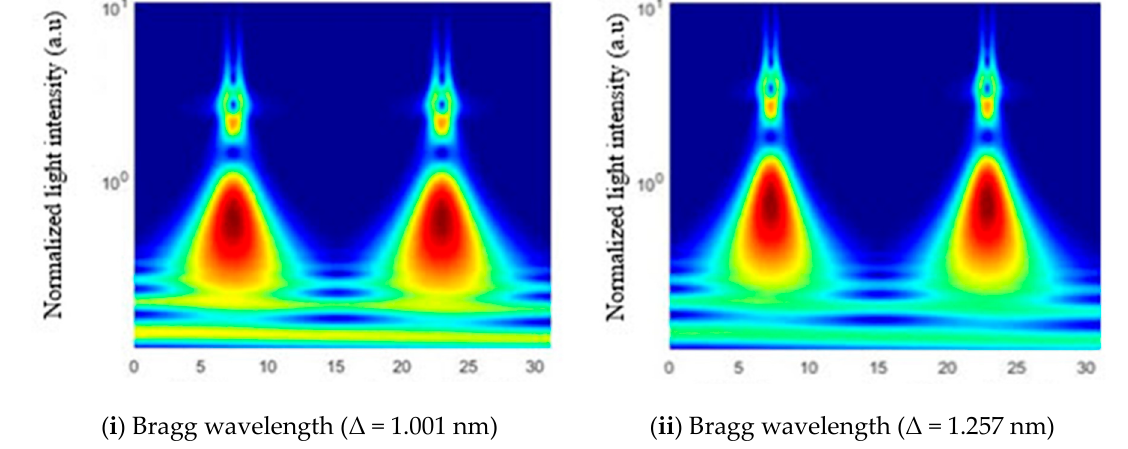
Figure 9. ( a ) Structure of porous medium and magnetic-field distribution in porous medium filled with ( b ) air, ( c ) oil, and ( d ) brine. 4. Discussion Dielectric materials have a large band gap due to being electrical insulators, exhibiting more energy excitement from valence to covalent bands and allowing electrons to move freely and conduct electricity (Figure 6). The formation of these bands is mostly a feature of the outermost electrons in an atom [42]. Band gaps (Table 1) are essentially leftover energy ranges that are not covered by any band and that resulted from finite widths of energy bands, with widths dependent upon the degree of overlap in the atomic orbitals from which they arise [43].